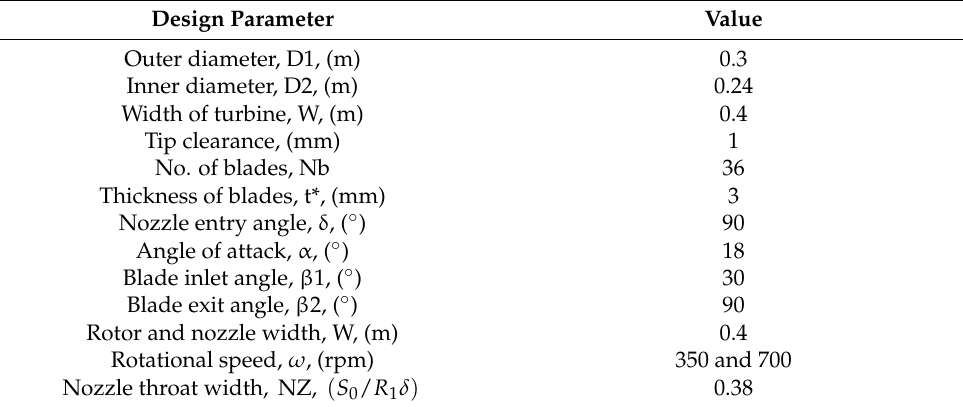
Figure 4. Experimental setup. Table 2. Detailed parameters of the cross-flow air turbine model for experiment.